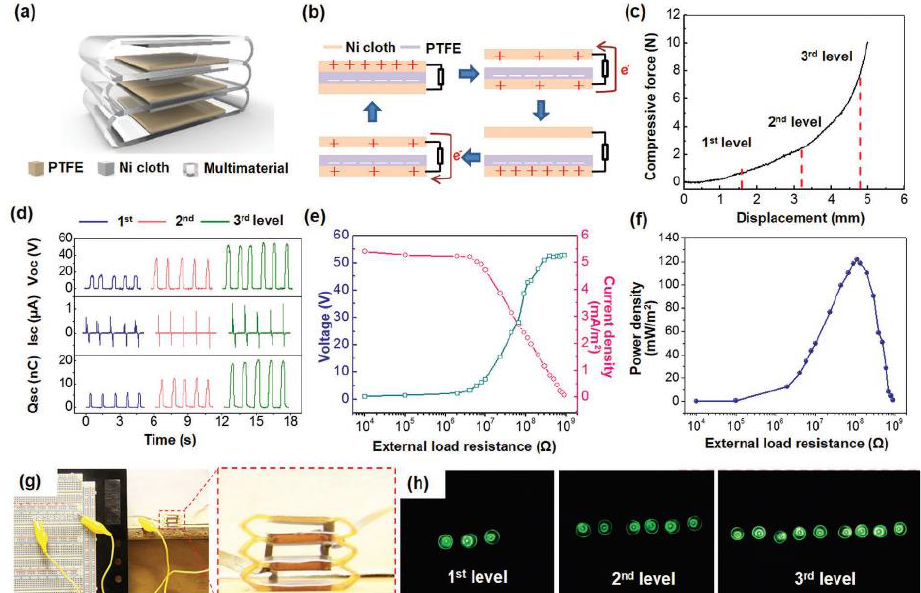
Figure 6. Design, working mechanism, and output performance of mTENG. ( a ) Schematic illustration of the 3D printing multi-material used as self-powered wearable electronics. ( b ) Schematic illustration of the electricity-generation process of the single-level contact separation. ( c ) Force – displacement curve of compressive test of the three-layer multi-material showing three stages of deformation. ( d ) The output performance of TENG in the different levels of contact-separation mode, including Voc, Isc, and Qsc. ( e ) Relation between the instantaneous output voltage and current density with the external load resistance. ( f ) Relation between the instantaneous output power density with the external load resistance. ( g ) The m-TENG was used as an energy harvester to lighten LEDs. ( h ) The mTENG can lighten 3, 6, and 9 LEDs by compression with the first, second, and third levels of deformation. [ K. Chen et al., “Dynamic Photomask -Assisted Direct Ink Writing Multimaterial for Multilevel Triboelectric Nanogenerator,” Adv. Funct. Mater. , vol. 29, no. 33, p. 1903568, 2019, Copyright Wiley-VCH GmbH. Reproduced with permission.].